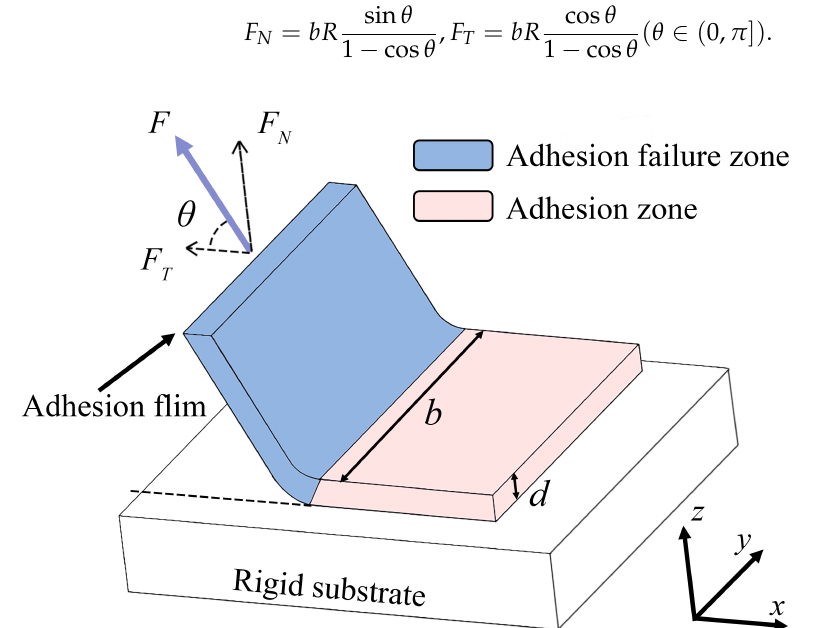
Figure 1. Adhesion film peeling force